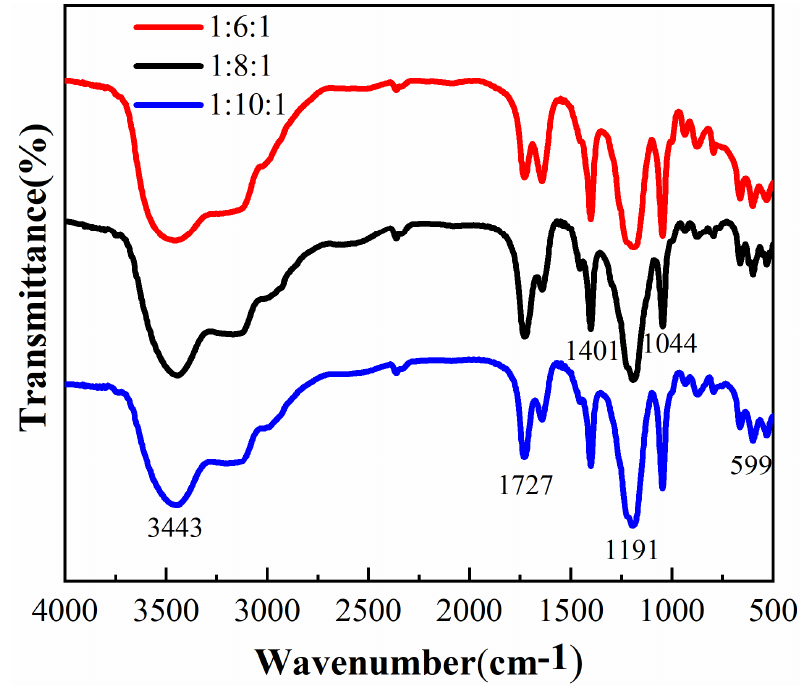
Figure 2. Infrared spectrum of HEMA − AA − SAS .